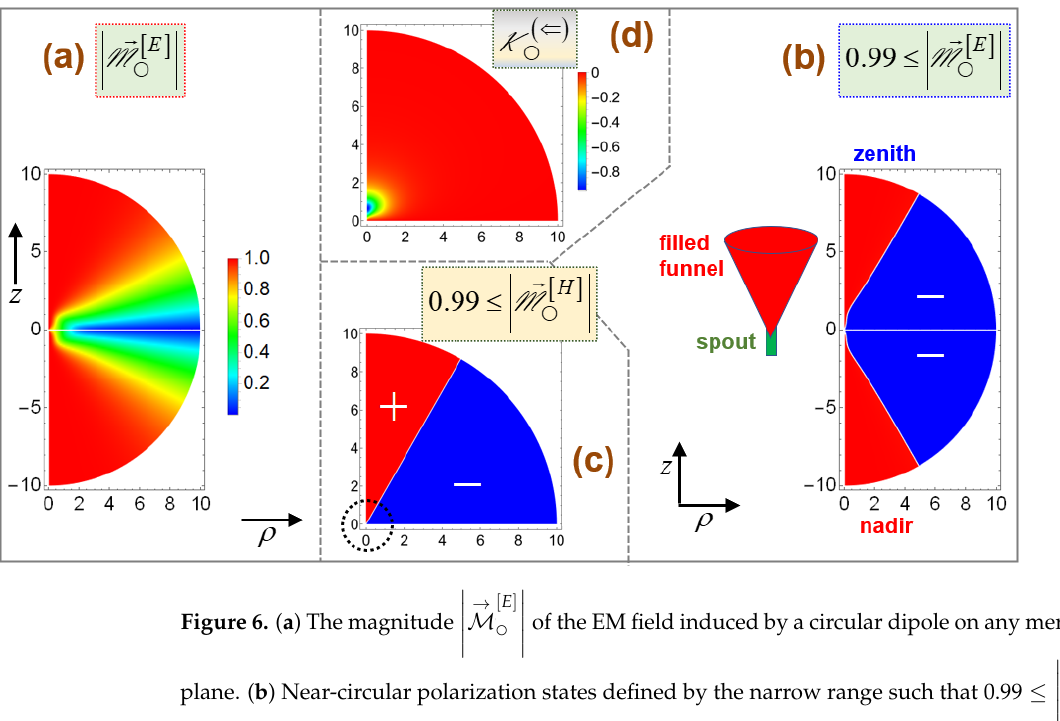
state of perfect circular polarization is not accessible over the whole space.